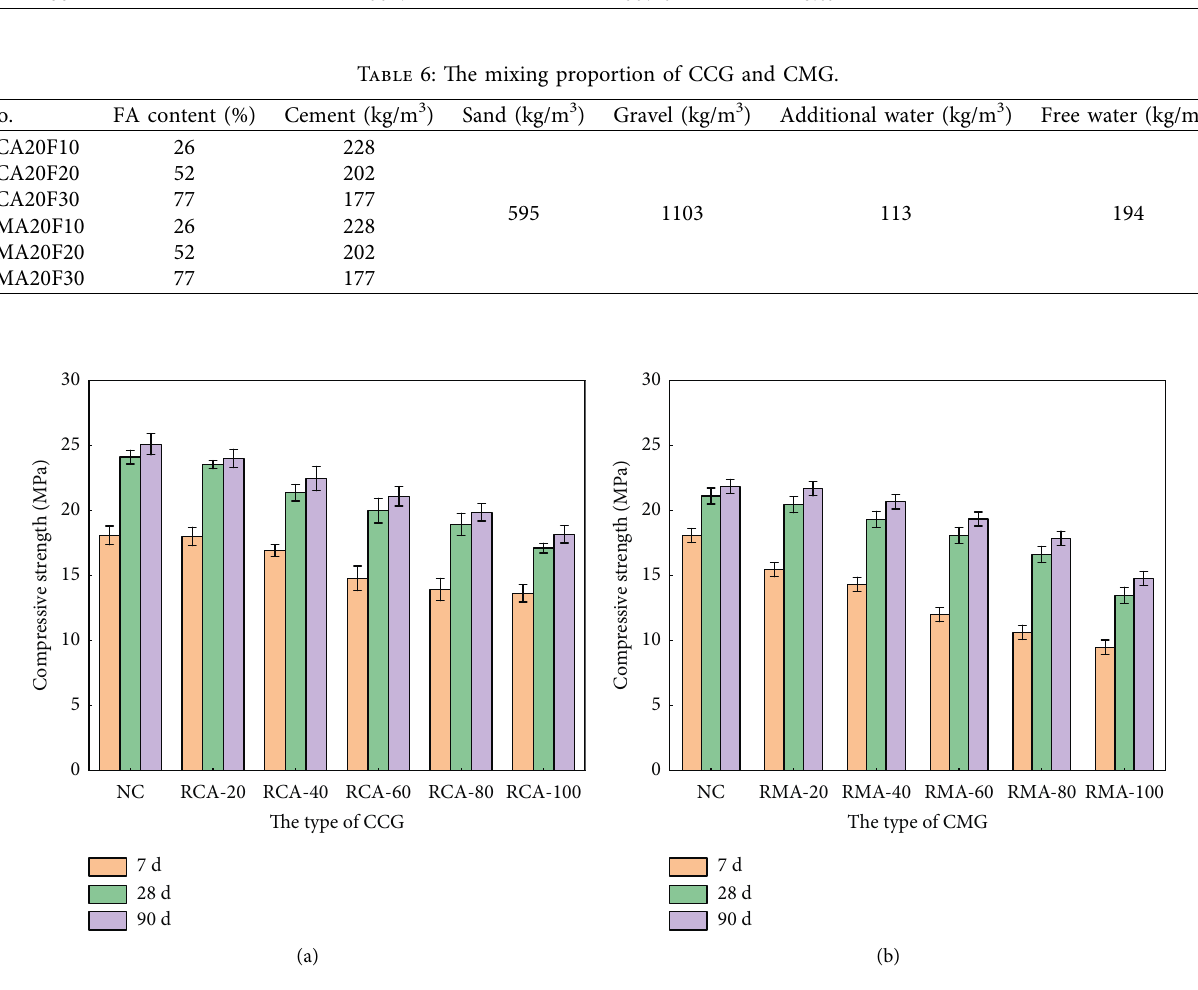
Figure 2: The effect of RCA and RMA with different dosages on compressive strength of CCG and CMG. (a) CCG, (b) CMG.